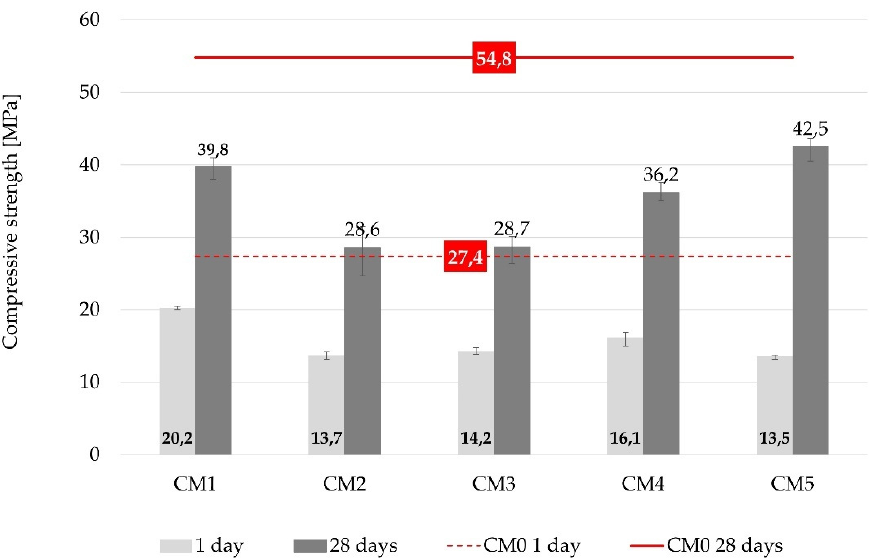
Figure 6. Compressive strength of concrete mixtures after 1 and 28 days.